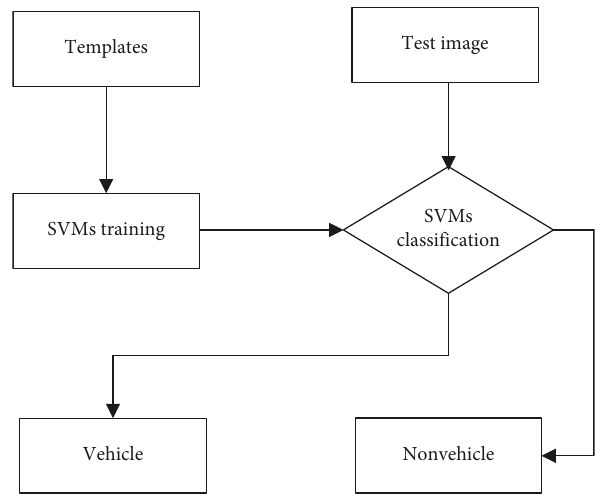
Figure 8: The flowchart of SVM